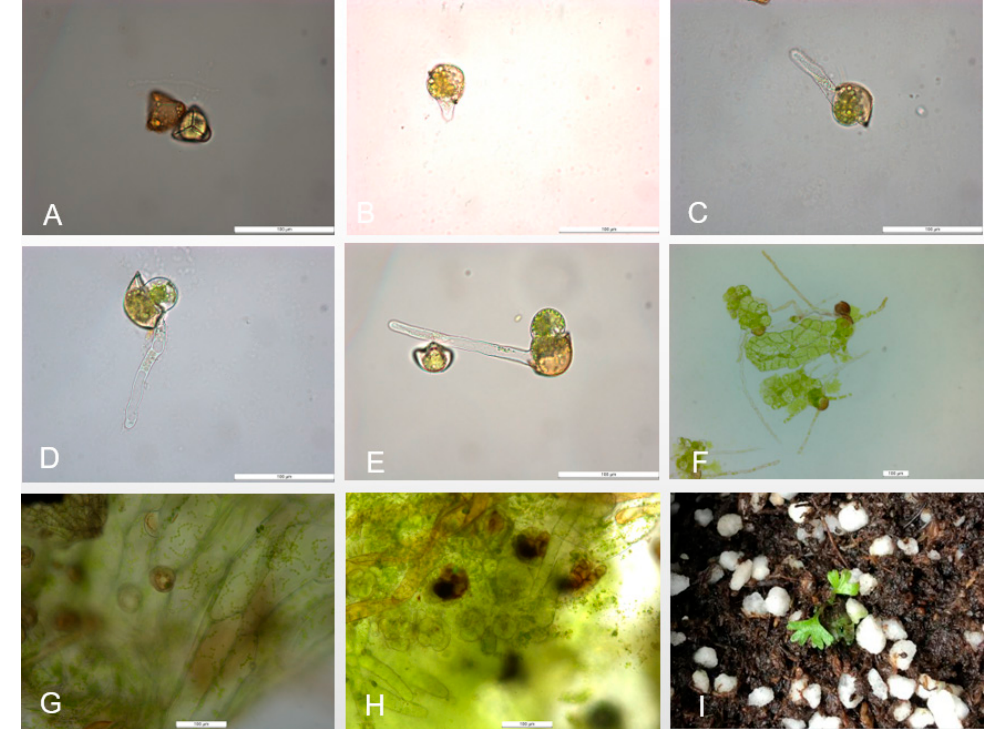
Figure 1. Spore germination process of Sphaeropteris lepifera . ( A ) Spore of S. lepifera ( center of each spore contains oil droplets ). Scale bar = 50 μ m. ( B – E ) Spore germination. Scale bar = 100 μ m. ( F ) Prothallus. Scale bar = 100 μ m. ( G ) Antheridium. Scale bar = 100 μ m. ( H ) Archegonium. Scale bar = 100 μ m. ( I ) Young sporophyte. Scale bar = 10 cm.